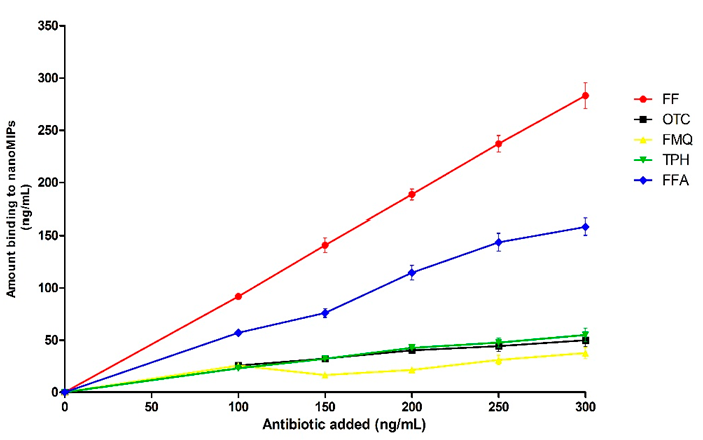
Figure 6. Competition between HRP-FF and antibiotics structurally similar and di ff erent to FF for binding to immobilized FF-nanoMIPs.